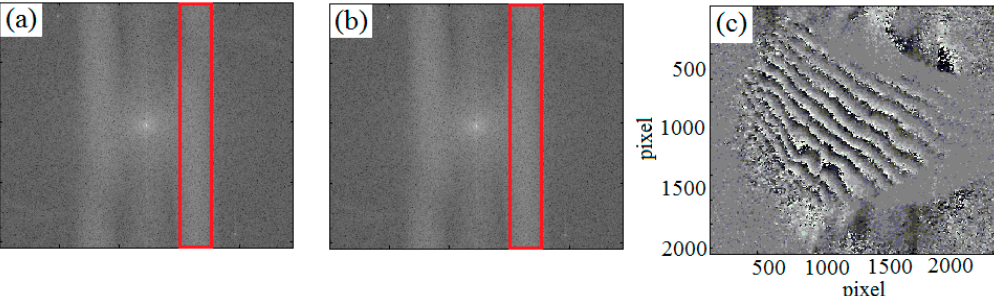
Figure 7. Spatial phase-shift testing results of out-of-plan strain, ( a ) frequency spectrogram of before deformation, ( b ) frequency spectrogram of after deformation, ( c ) phase difference diagram.